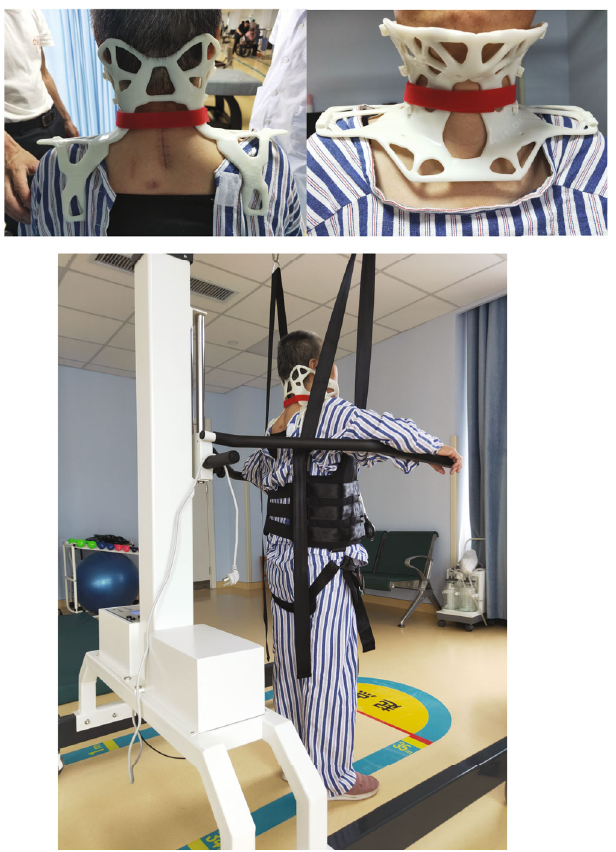
Figure 4: Patient wears orthoses for walking, sitting, and standing.